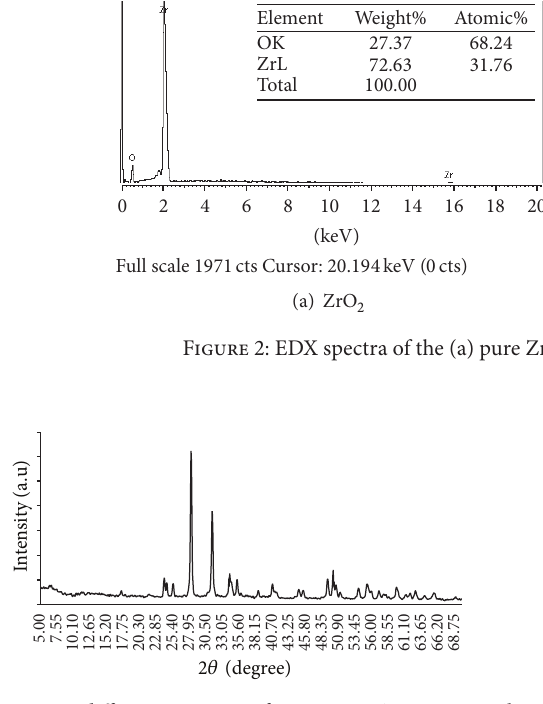
Figure 3: X-ray diffraction pattern of 0.01wt% Pt/ZrO 2 as a catalyst for oxidation of cyclohexanol to cyclohexanone.